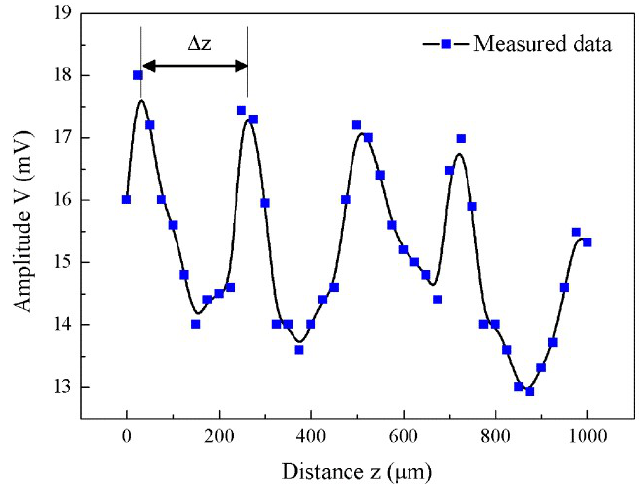
Figure 4. The V(z) curve representing the transducer output versus the lifting location of transducer. Figure 4. The V ( z ) curve representing the transducer output versus the lifting location of